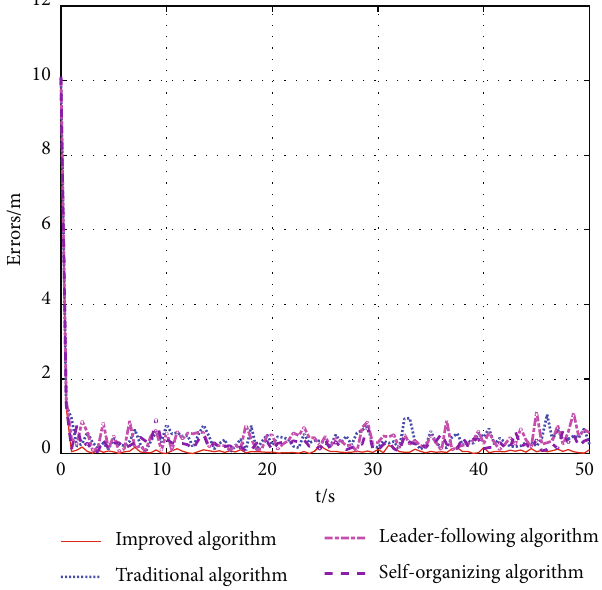
Figure 7: The error between the geometric centre trajectory and the target trajectory.